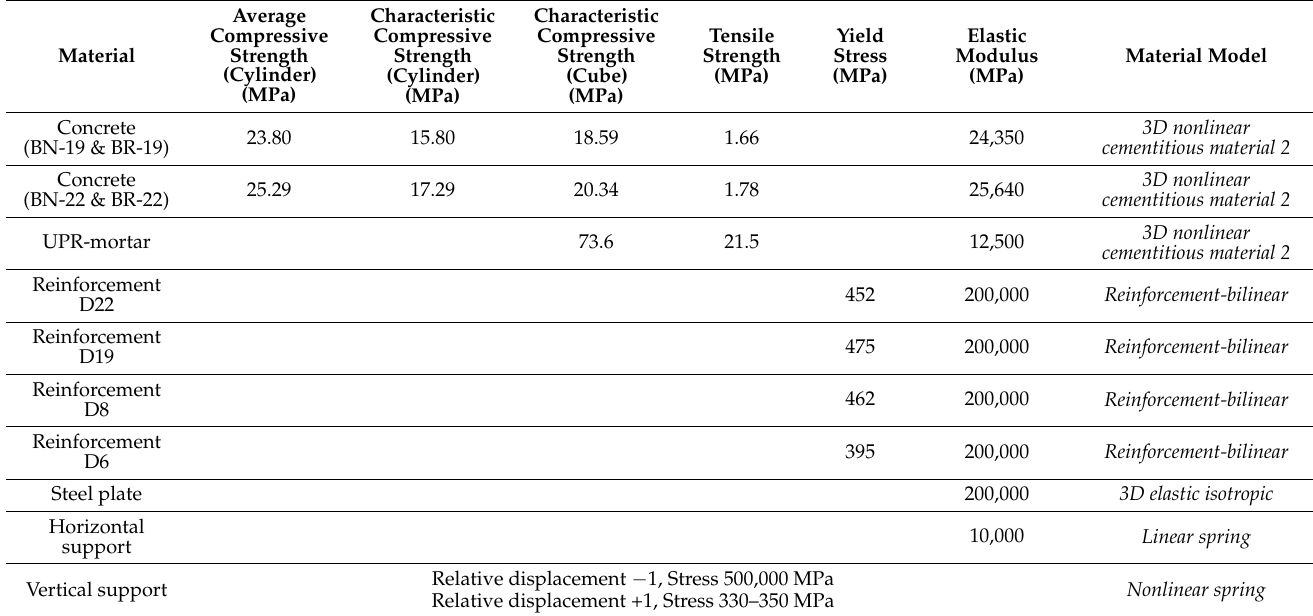
Figure 4. Finite element model of normal beam ( left ) and repair beam ( right ). Table 2. Properties of materials and their corresponding constitutive model.